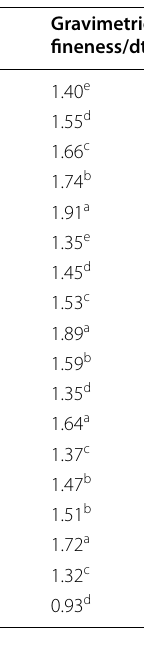
Table 6 Average results of single fiber testing by fiber length group